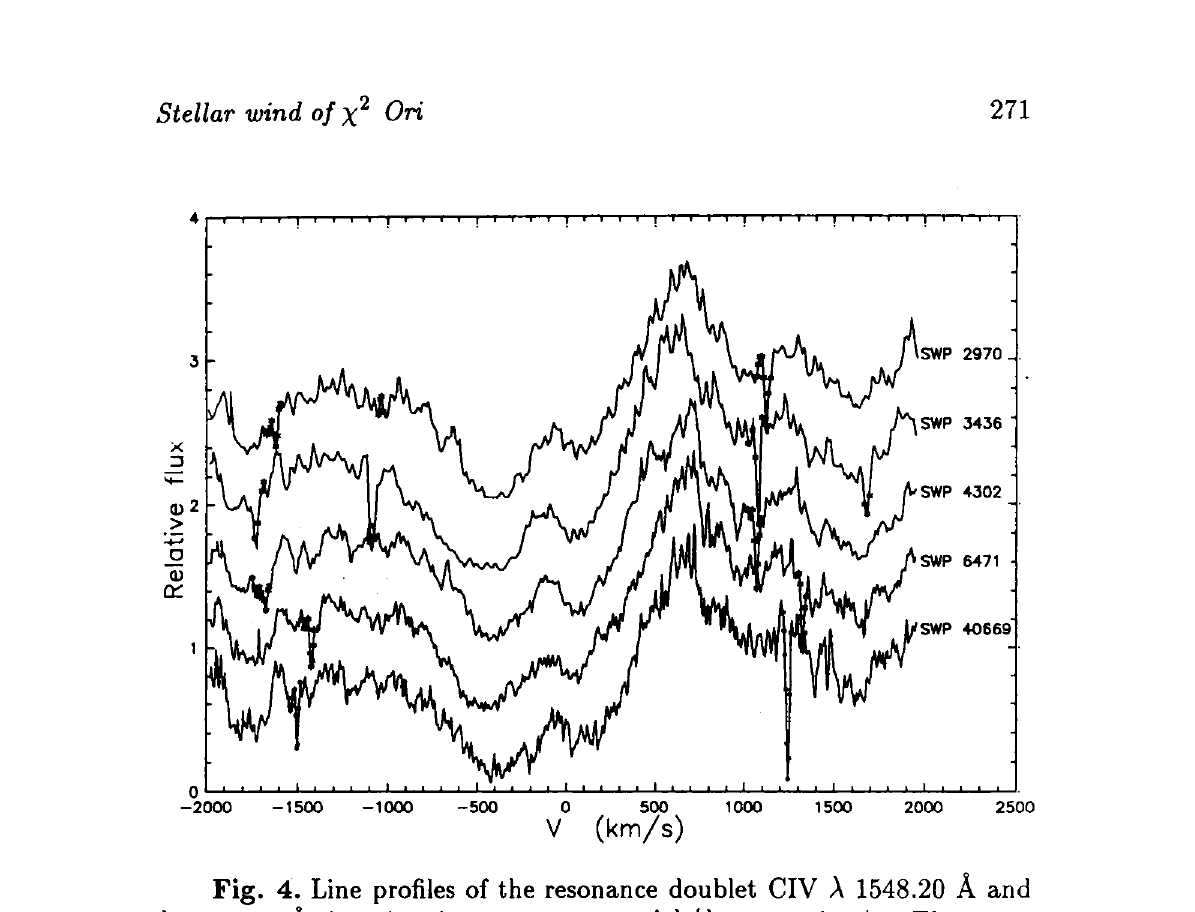
Fig. 4. Line profiles of the resonance doublet CIV A 1548.20 A and A 1550.77 A. For doublet components cAA/A « 600